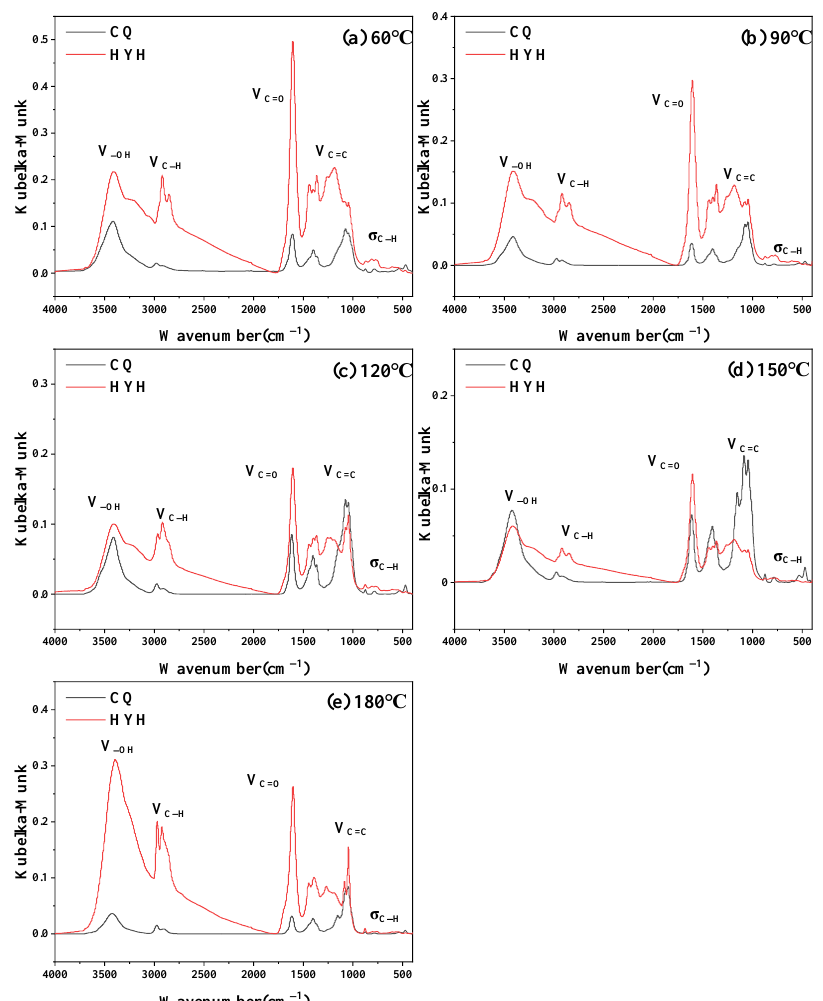
Figure 11. FTIR spectra of coal samples at different temperatures. The results of peak fitting based on the FTIR spectra are shown in Figure 12, and variations of CH 3 , C=O, COOH functional groups in HYH and CQ coal samples are illus- trated in Figures 13 – 15.